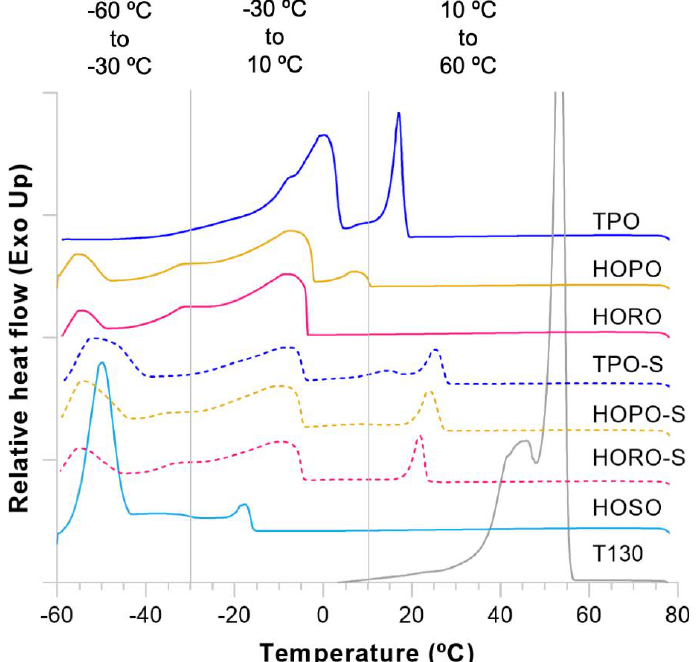
Figure 2. Differential scanning calorimetry of crystallization curves (exothermic thermogram) for oils, emulsifier and shortenings. Deviations above the baseline are exothermic; Deviations below the baseline are endothermic.